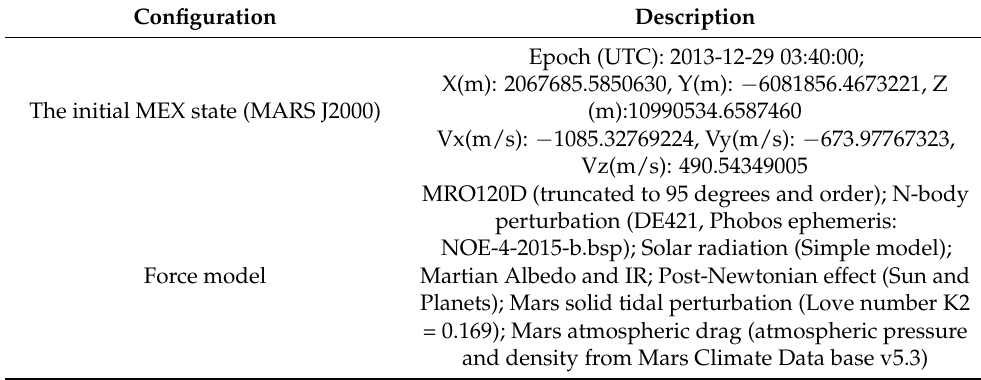
Table 1. The configuration of the orbit integration.